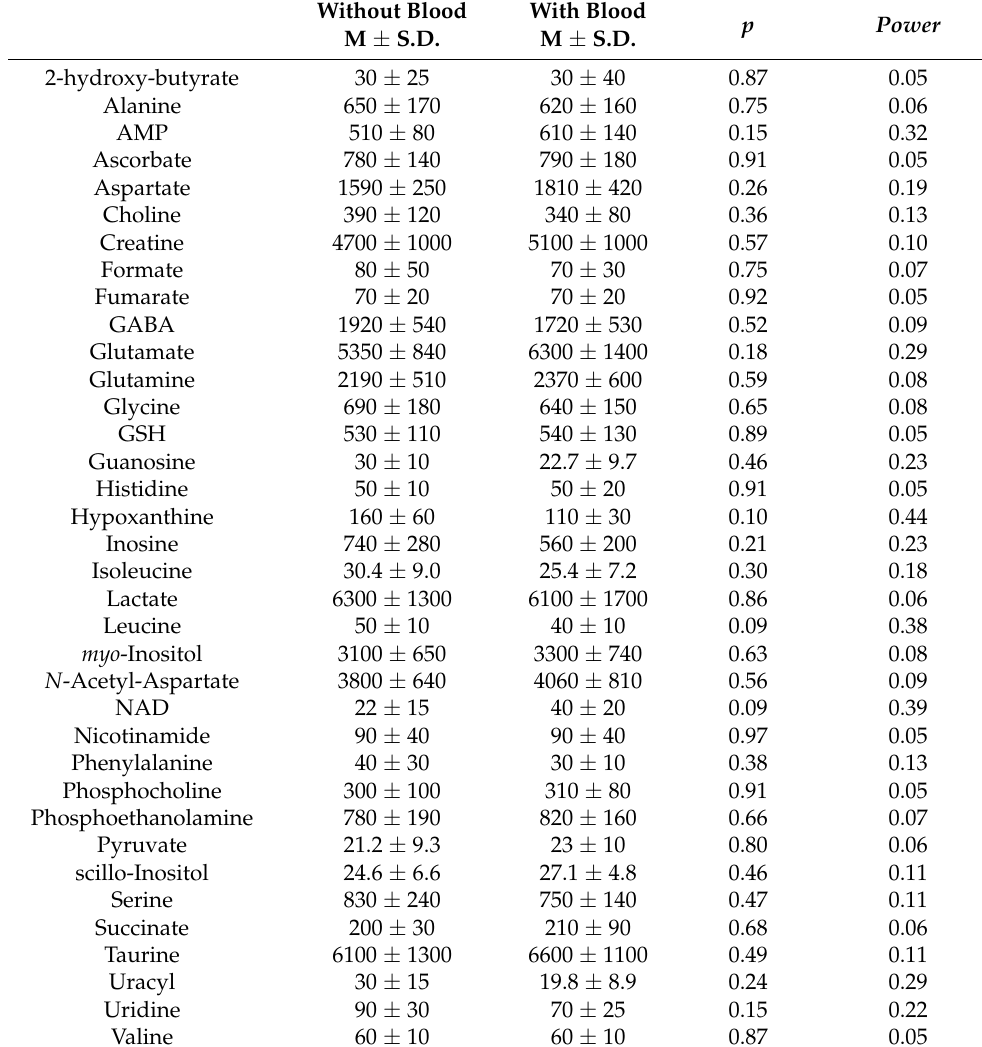
Table 1. Metabolite concentrations (nmol/g) in the brain tissue of animals from groups A and B. The comparison of groups was performed by Student’s t -test with the estimation of the test